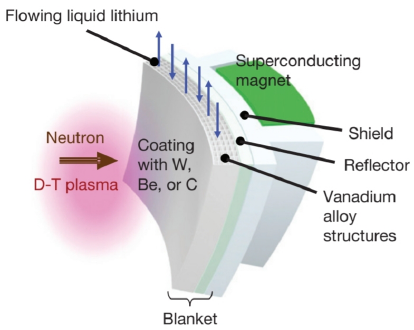
Figure 14. Illustration of a self-cooled Li blanket with structural material V-4Cr-4Ti. Reprinted with permission from Ref. [88]. Credit c (cid:13) Elsevier,